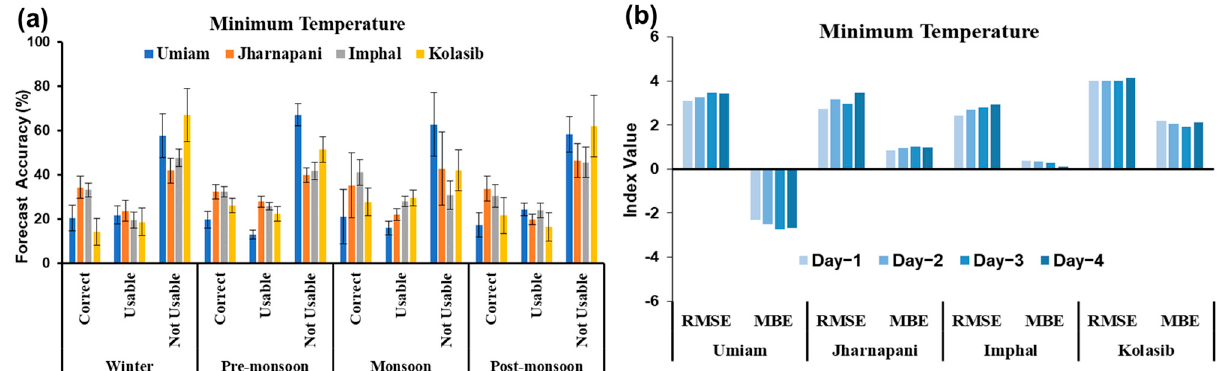
Figure 3. Quantitative ( a ) and statistical evaluation ( b ) of minimum temperature forecast over various locations of the northeastern hill region of India.